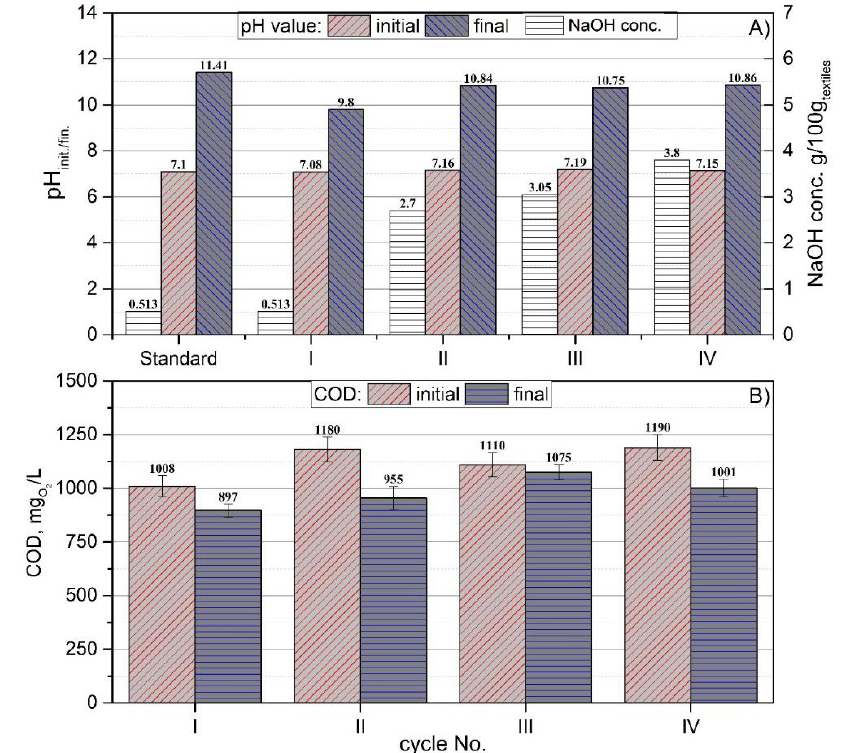
Figure 4. Ozonation cycles I–IV: ( A ) initial and final pH values, NaOH concentrations g/100g textiles , ( B ) initial and final COD values, mg O2 /L.